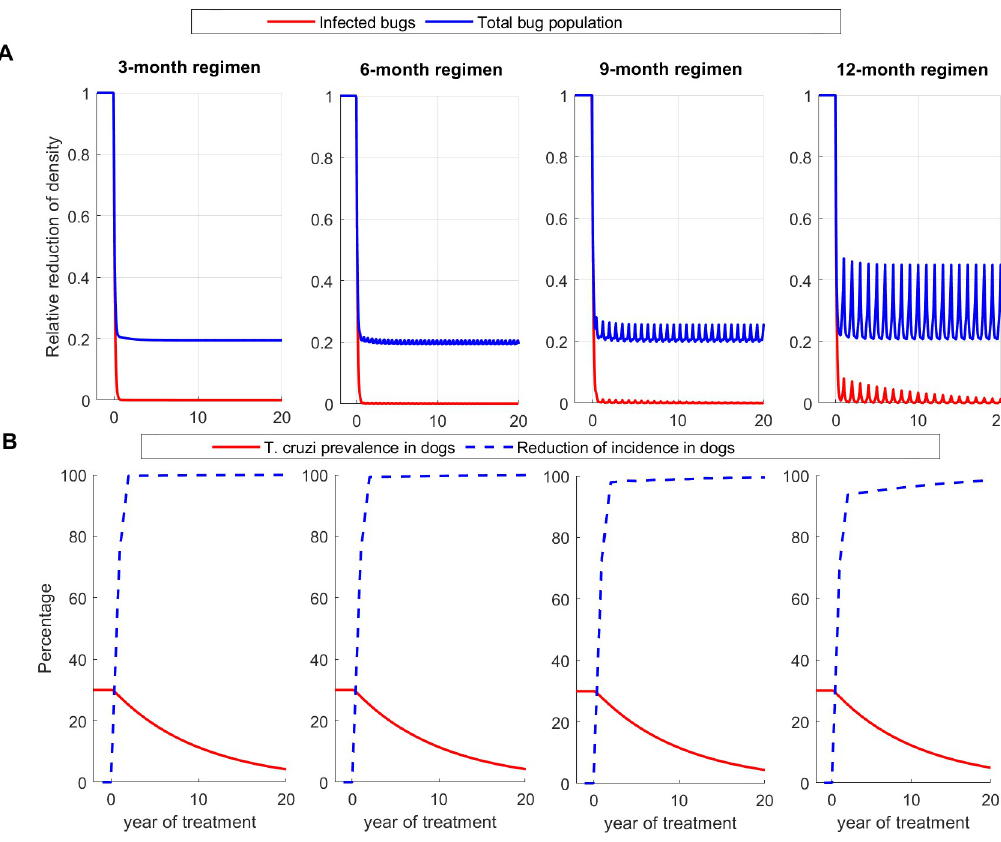
Fig 3. Effectiveness of systemic insecticide treatment of dogs with fluralaner for the control of canine Chagas in a high transmission setting with 3-month, 6-month, 9-month, and 12-month treatment regimens using Model 1. (A) Reduction of total population density (blue) and T . cruzi infections in triatomines (red), (B) Reduction of T . cruzi infection prevalence (red) and incidence in dogs (blue). Effectiveness is evaluated using the single vector-host model without seasonality.